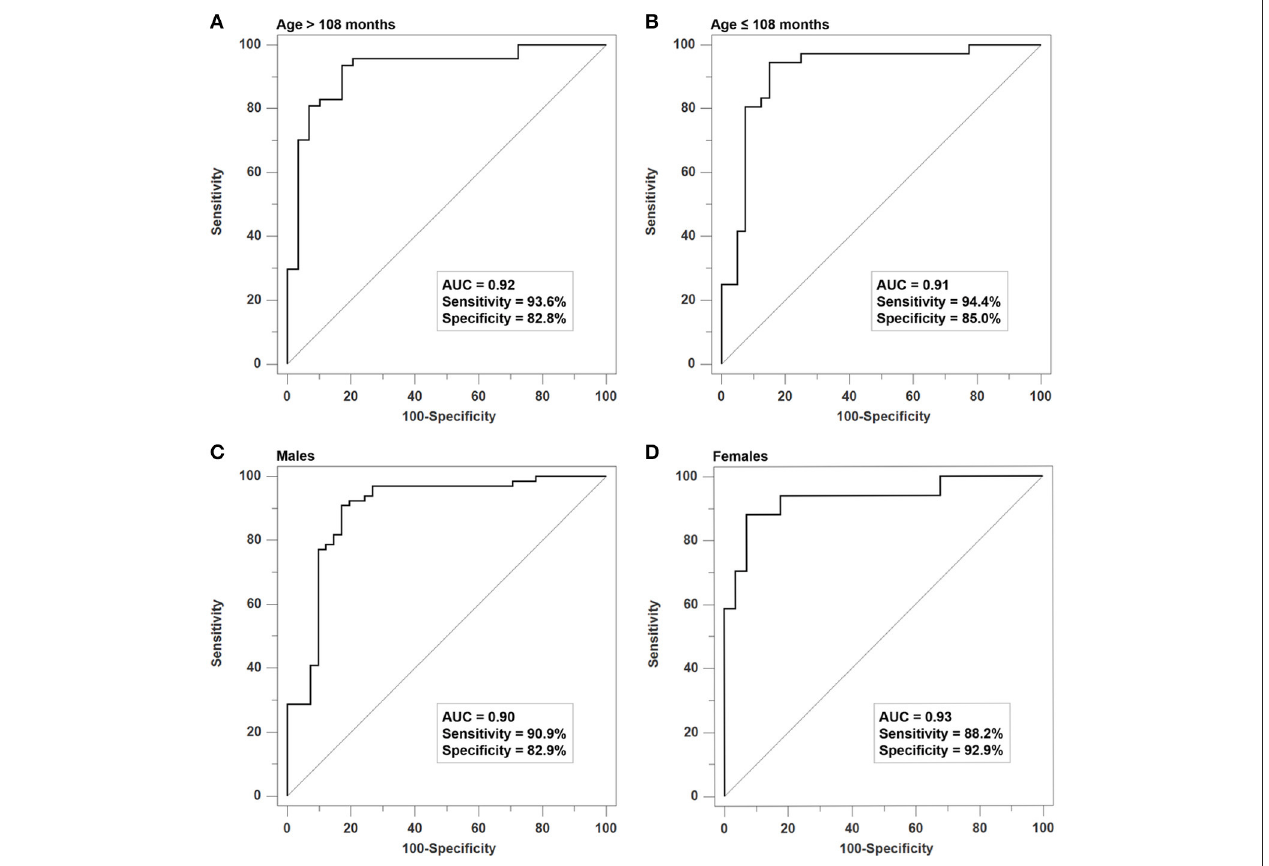
FIGURE 3 | Sensitivity analyses of the SVM Model for age- and gender-stratified samples. The SVM model has good discriminative validity for differentiating patients from controls in (A) the older group ( ≤ 108 months, AUC: 0.93), (B) the younger group ( > 108 months, AUC: 0.91), (C) males (AUC: 0.90), and (D) females (AUC: